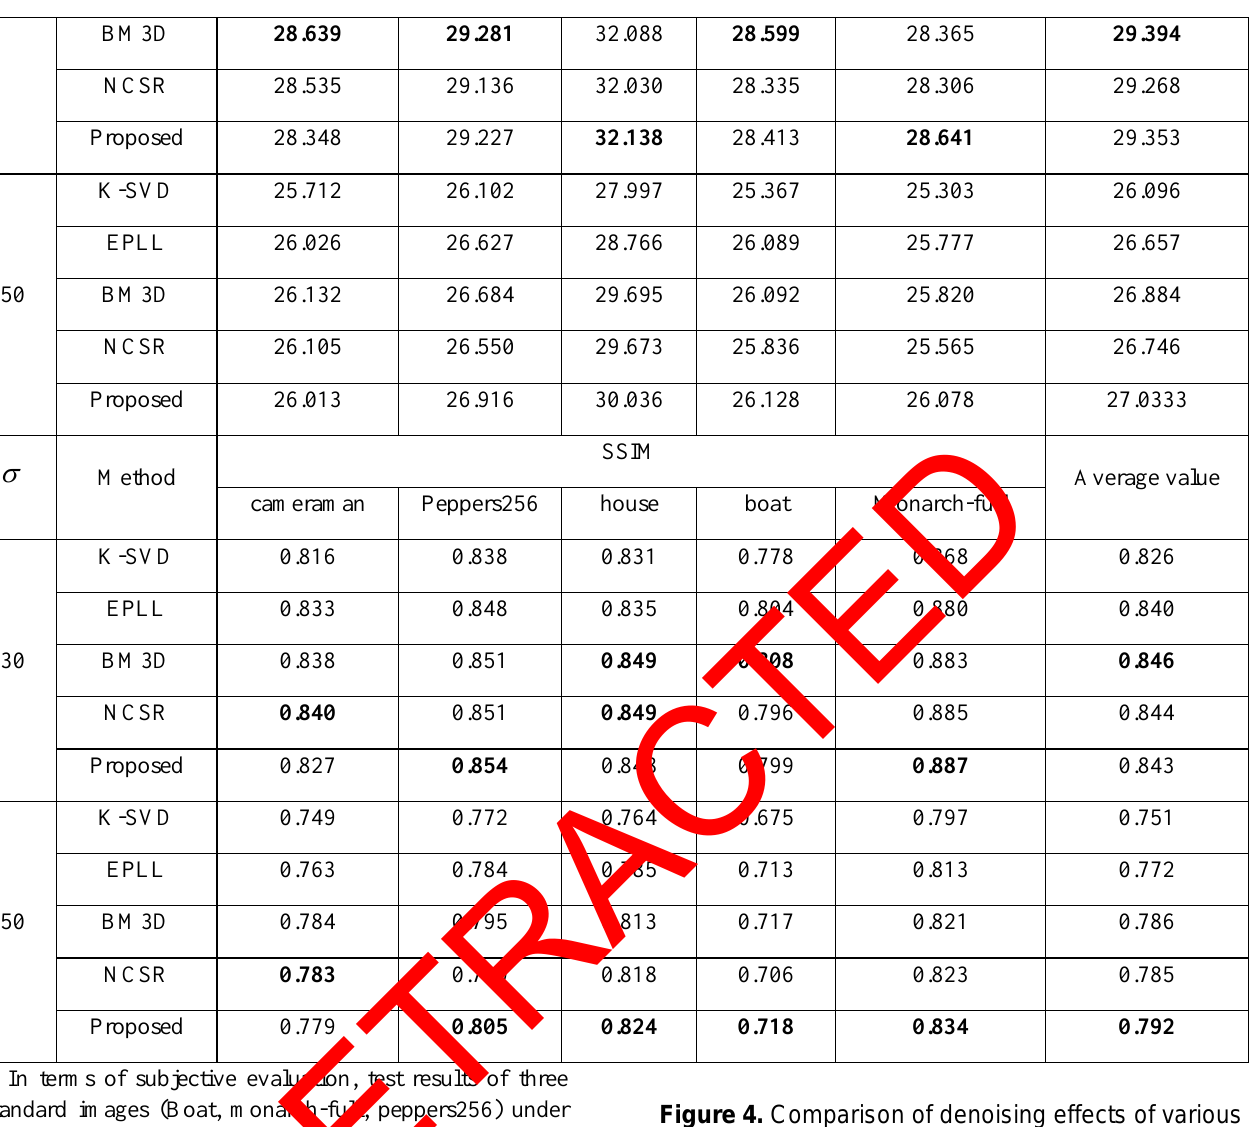
Figure 4. Comparison of denoising effects of various algorithms under the strong noise of  =100